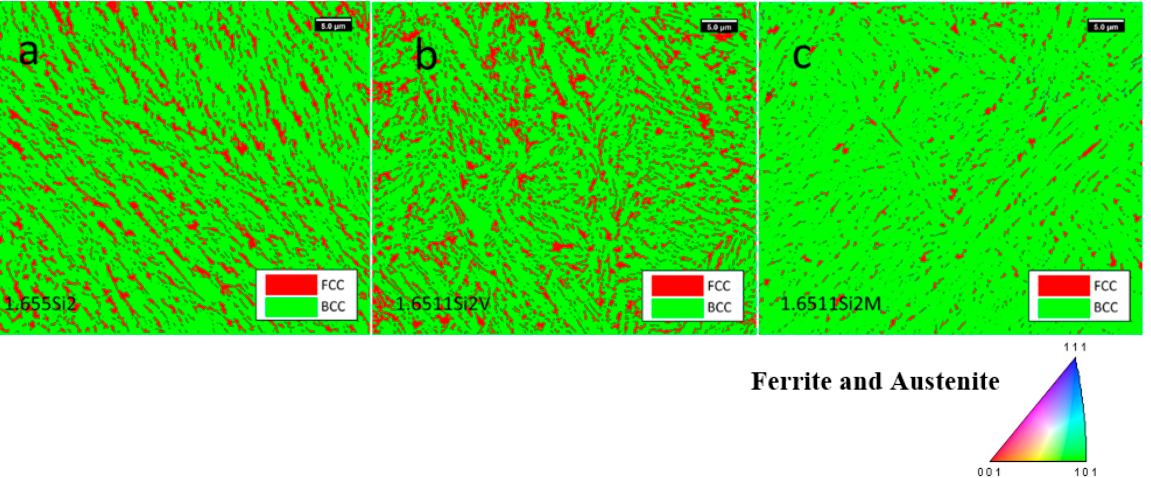
Figure 8. EBSD phase map of the ( a ) 1.6511Si2, ( b ) 1.6511Si2V, and ( c ) 1.6511Si2M samples. The red phase shows the retained austenite. Note: Retained austenite increased with vanadium and decreased with the rare earth elements .